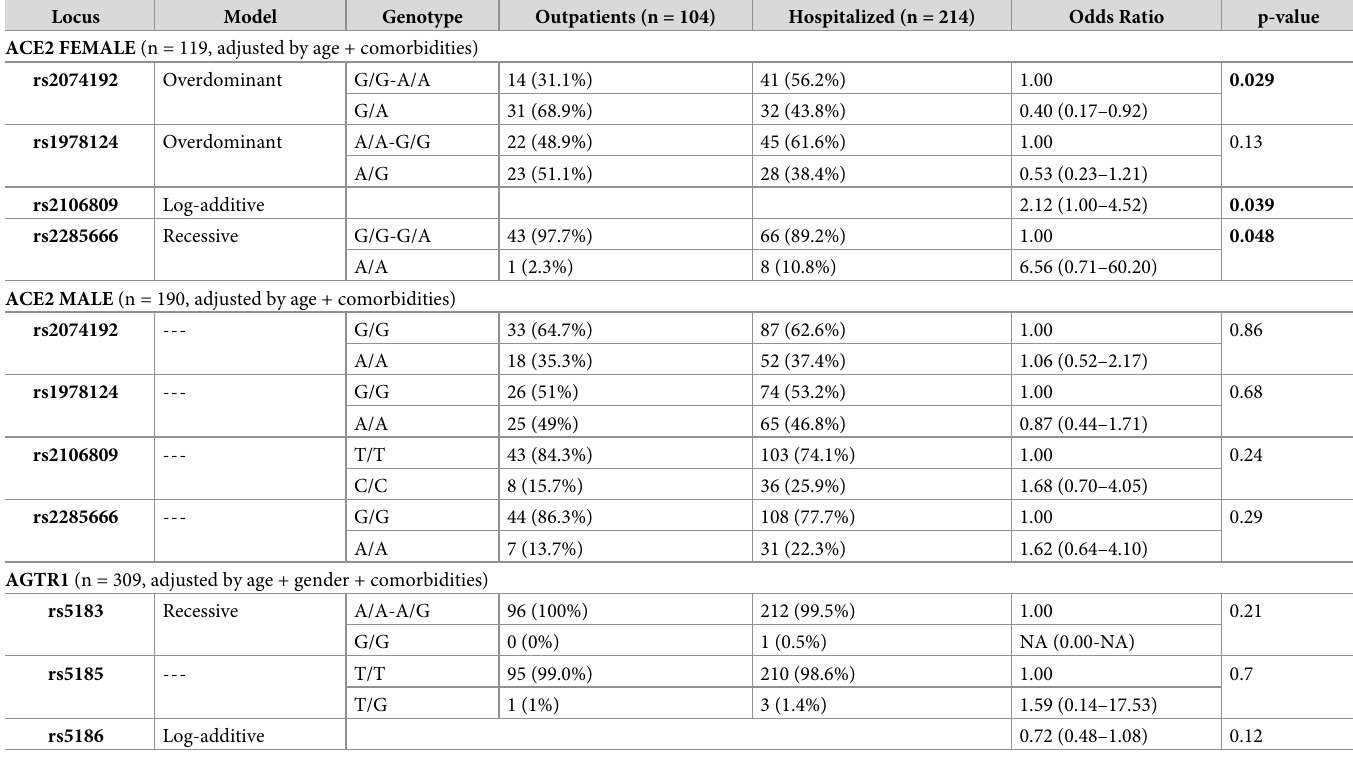
Table 3. Genotype and allele frequencies of ACE2 and AGTR1 SNPs in hospitalized and non-hospitalized COVID-19 cases. Locus Model Genotype Outpatients (n = 104) Hospitalized (n = 214)